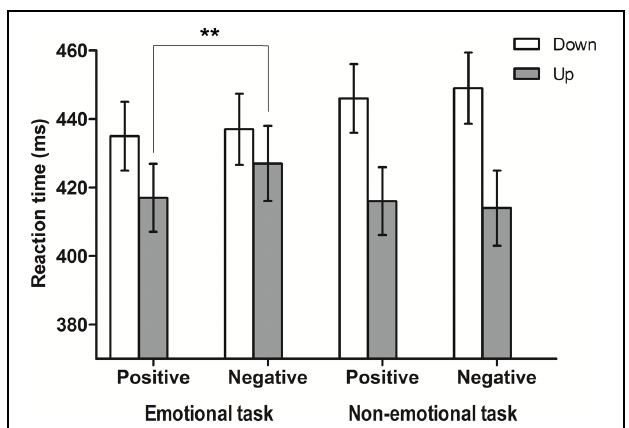
FIGURE 3 | Means of the median reaction times (ms) for the three-way interaction group, emotional valence, and position in Experiment 2. Error bars represent 95% CIs adjusted for within-subjects designs (Cousineau, 2005). ∗∗ p < 0.01.